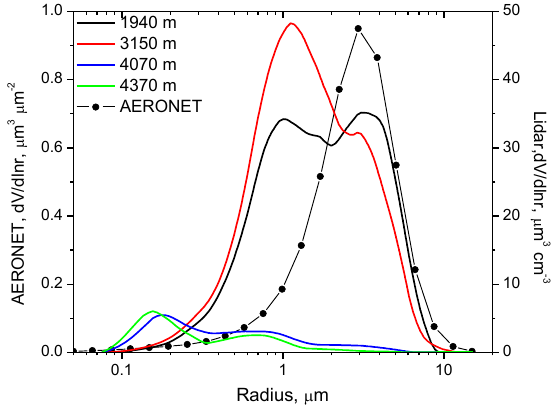
Figure 18. Particle size distributions retrieved from the measure- ments on 10 April for four height layers of 1940, 3150, 4070, and 4370m. Symbols show the PSD provided by AERONET on 9 April at 18:00UTC, inversion level 1.5.